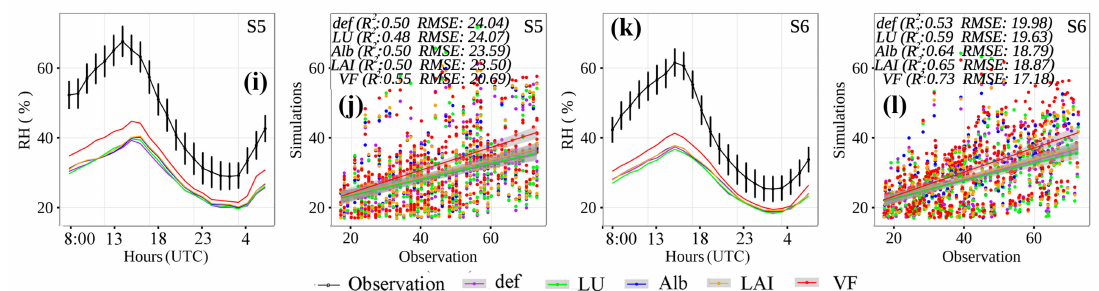
Figure 7. Comparisons of hourly averaged 2 m relative humidity (RH) between observations and five simulations ( a , c , e , g , i , k ), and corresponding scatter diagram ( b , d , f , h , j , l ) at six stations (S1–S6) in 2010 and 2012. The five simulations are as follows: def (using default LU, albedo, LAI, and VF data); LU (using actual LU data), Alb (using actual LU and albedo data), LAI (using actual LU, albedo, and LAI), and VF (using all of actual LU, albedo, LAI, and VF